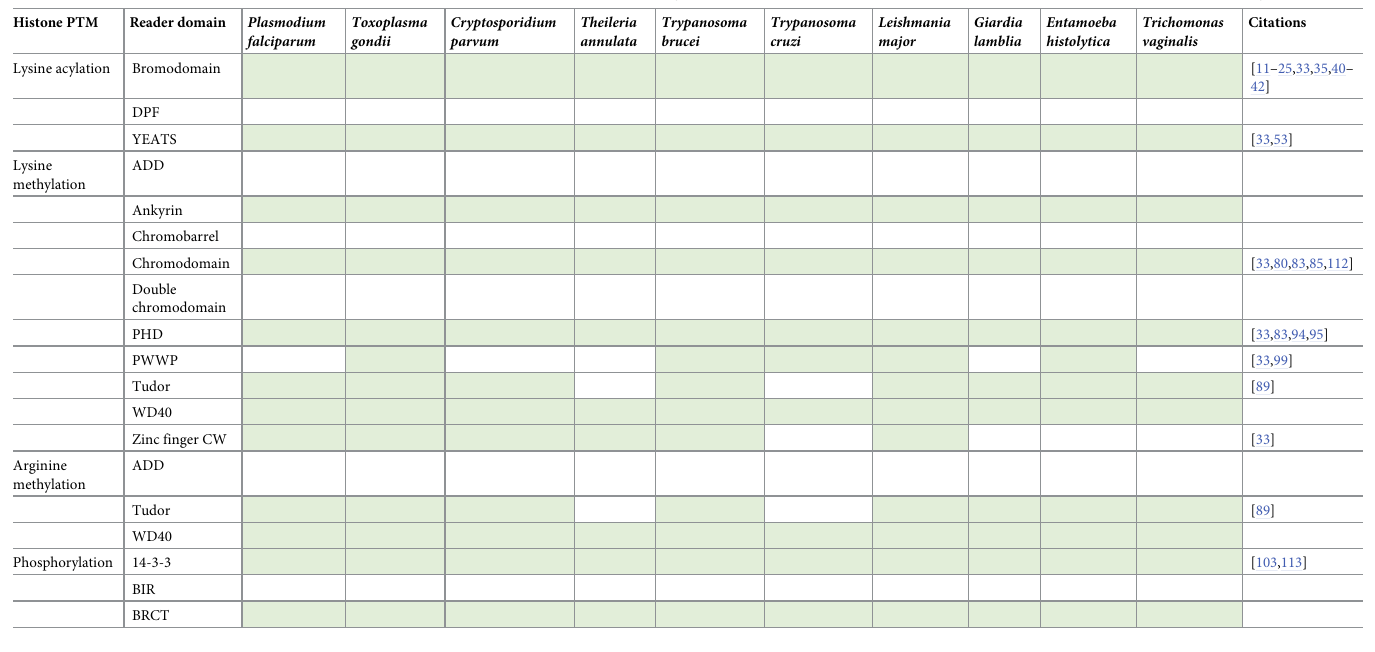
Table 1. Reader domains of histone PTMs in protozoan parasites. Green shading indicates the presence of a particular reader domain in the corresponding